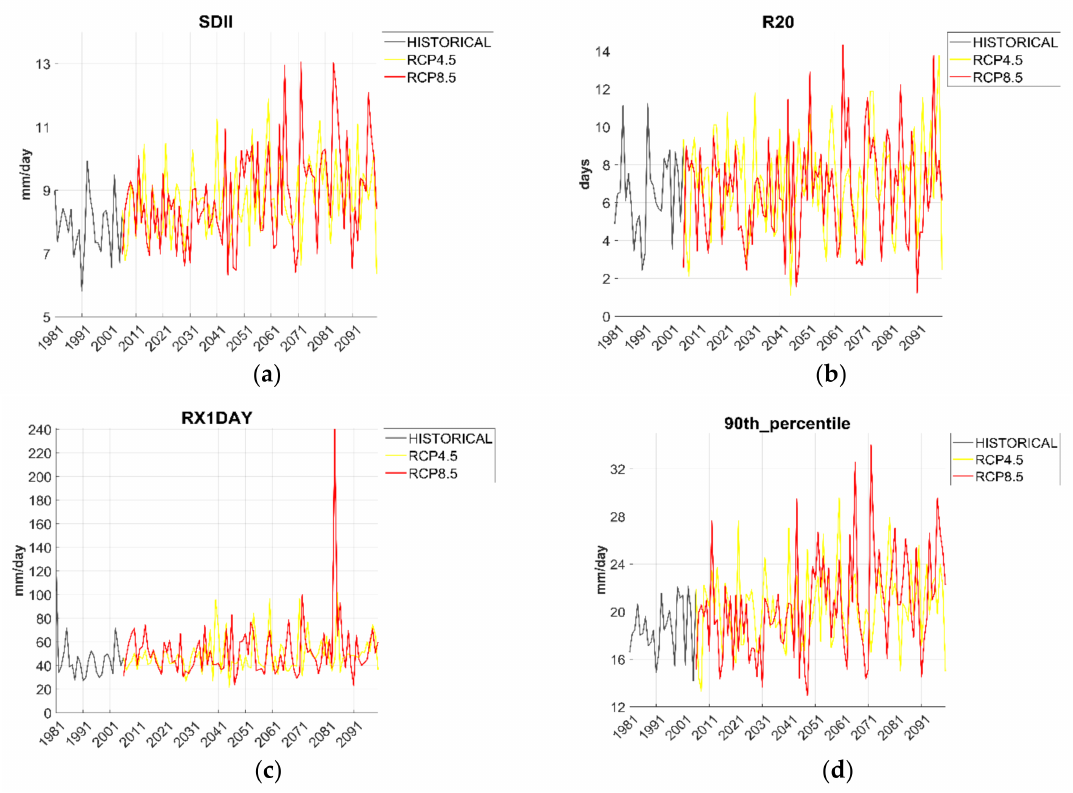
Figure 6. Time series of ( a ) SDII, ( b ) R20, ( c ) Rx1day, ( d ) 90p-Prec under IPCC RCP4.5 and RCP8.5